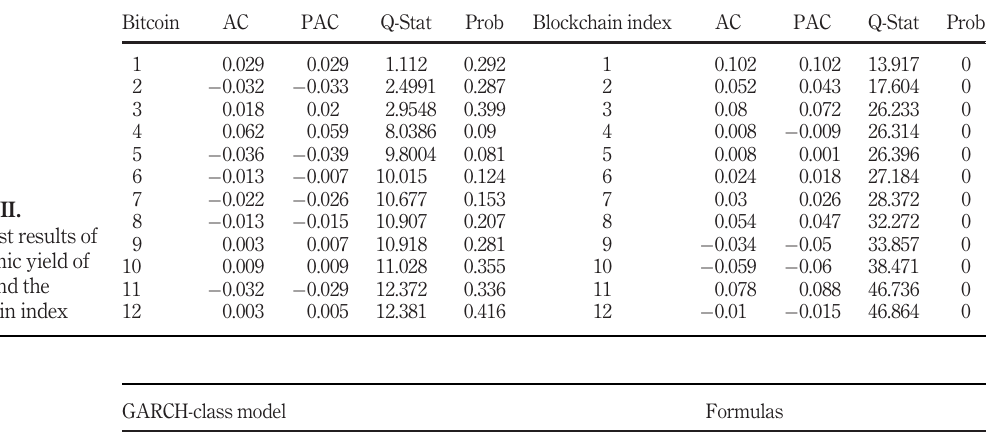
Table VIII. Formulas of GARCH- class model